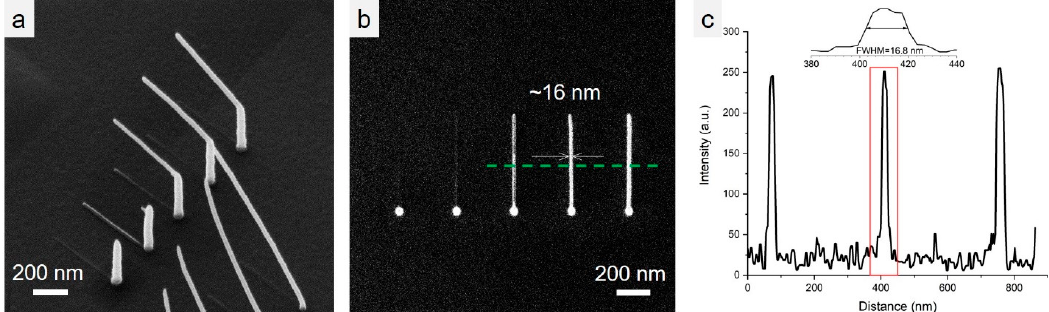
Figure 5. Examples of grown structures with ~16 nm features at full width half maximum (FWHM). ( a ) Side view of the structures with increasing dwell time of 4, 6, and 8 ms, respectively. ( b ) Top view of the structures in ( a ). ( c ) Line profile of the structures along the green line shown in panel ( b ) with zoom in of FWHM = 16.8 nm pillar.